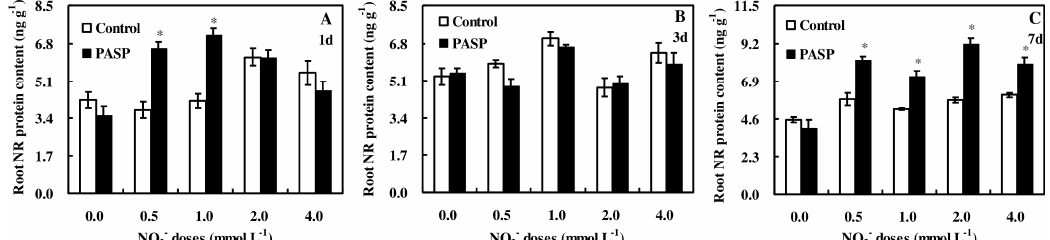
Figure 8. Root NR protein content analysis by ELISA on the 1st ( A ), 3rd ( B ), and 7th ( C ) day after PASP treatment. The PASP and control indicate seedlings with and without PASP addition, respectively. Data were presented as the mean ± standard error of 15 plants in each treatment. *, Statistically significant differences between PASP treatment and control within each nitrogen level, according to Student’s test at p < 0.05.